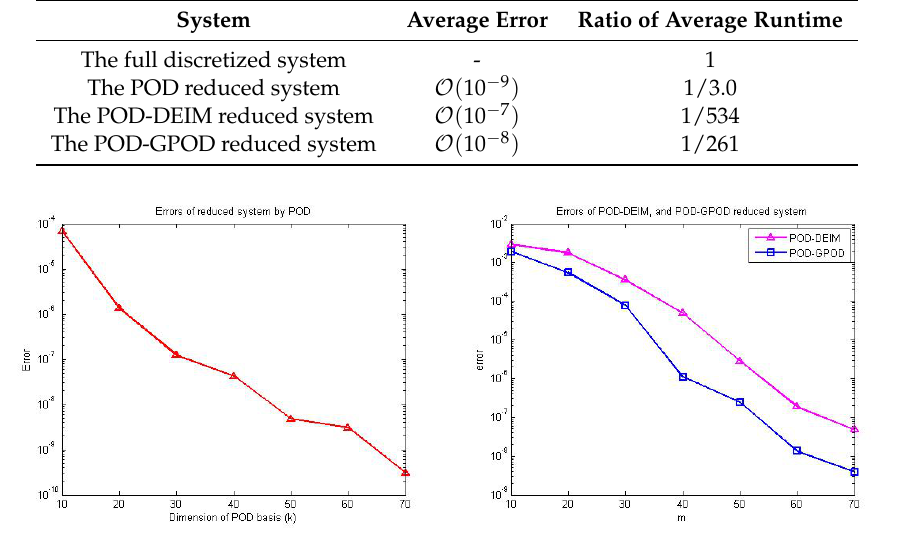
Figure 9. [Test 3] Average error plot of the approximation from POD reduced systems with parameter values (cid:101) = 0.0105, 0.01, and 0.0095, using different dimensions of POD basis k (left) and from the POD-DEIM and POD-GPOD reduced systems with different dimensions of nonlinear basis m for a fixed POD dimension k = 50